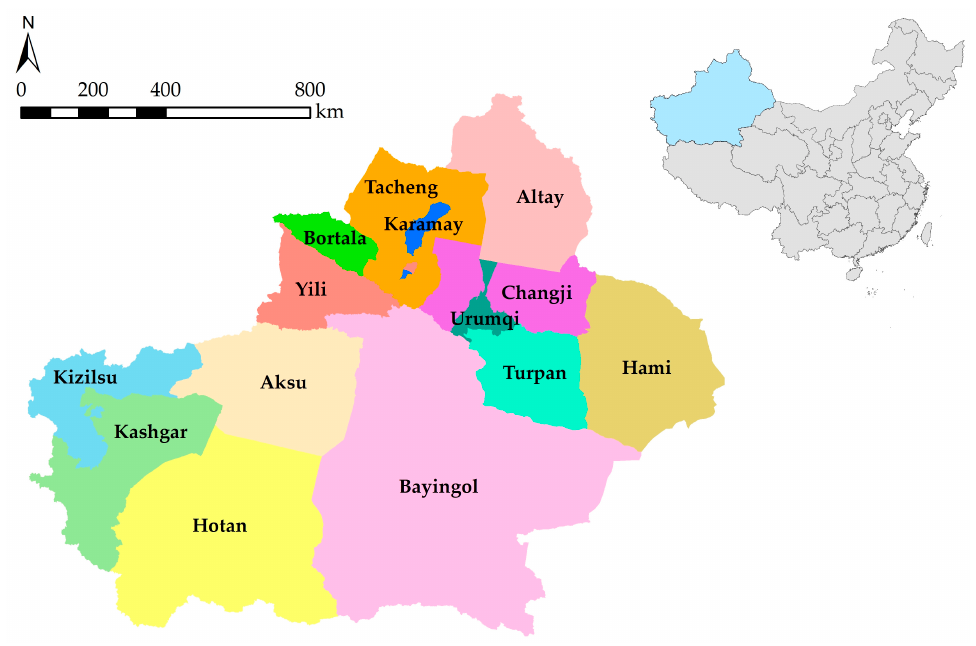
Figure 1. The location of the study area.